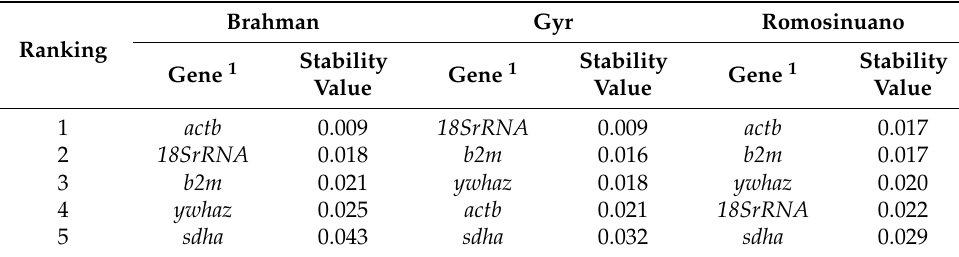
Table 2. Reference gene stability value ranked by NormFinder algorithm in different bovine breeds.